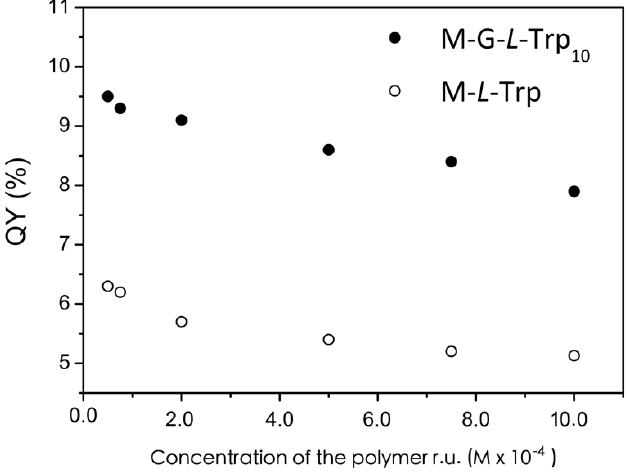
Figure 9. Quantum yields of M- L -Trp and M-G- L -Trp 10 recorded at pH 11 and increasing concentration of the polymer repeat units (r.u.).